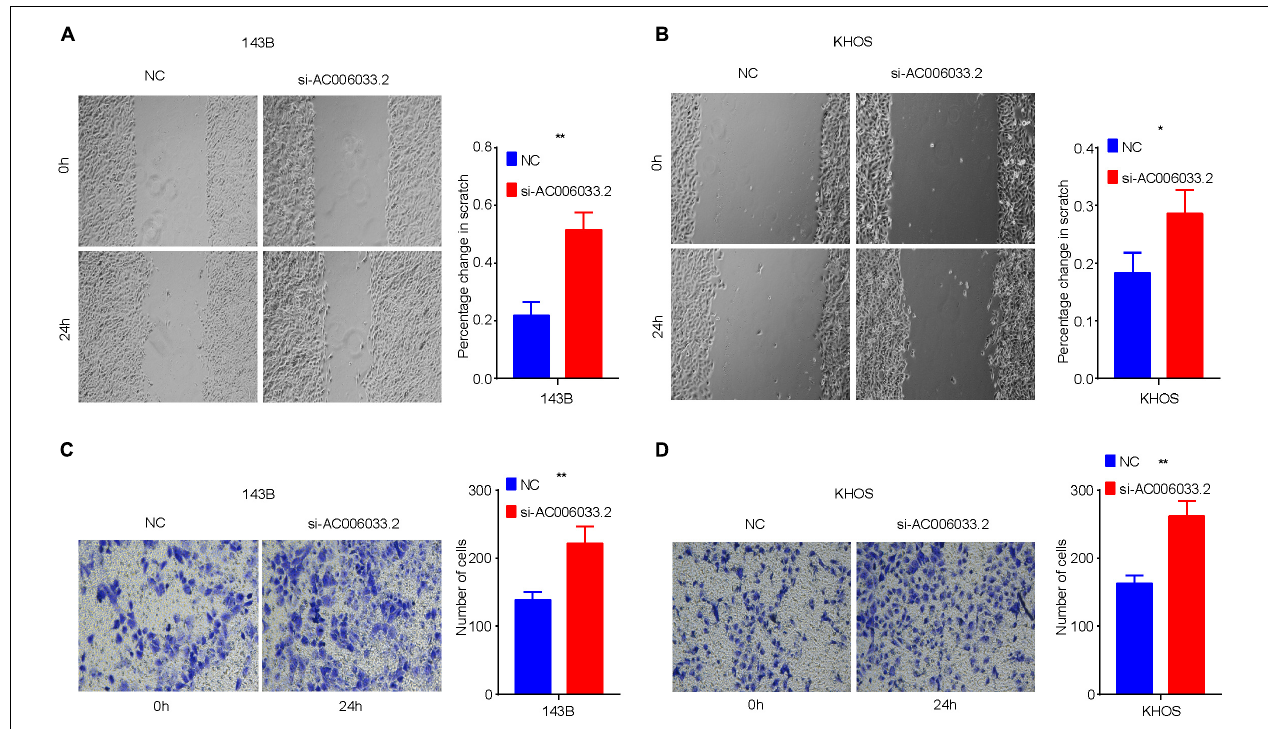
FIGURE 6 | Influence of AC006033.2 on migration and invasion ability of osteosarcoma. (A,B) Effects of AC006033.2 knockdown on the migration ability of osteosarcoma cells. (C,D) Effects of AC006033.2 knockdown on the invasion ability of osteosarcoma cells. * P < 0.05 and ** P < 0.01.